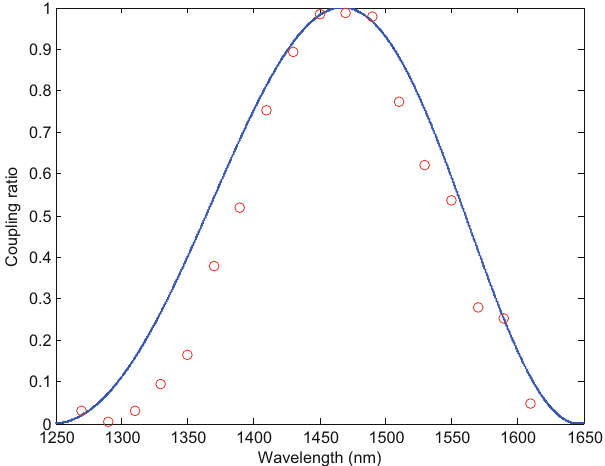
Figure 2. Relationship between the wavelength of the source and the coupling ratio. The coupling ratio of the 1 BS is defined as = , where I port 1 ( I port 2 ) is the output intensity of BS output 1(2). The theoretical r + port 1 2 relationships are based on the coupling model r = F 2 sin 2 ( C ω / F ) given in ref. 11, where F 2 is the maximal coupled power, C is the coupling coefficient, and ω is the heat source width. The red dot is the experimental measurement result, and the curve is the theoretical result. The coupling ratio changes from 0.003 to 0.968 with the wavelength changing from 1290 nm and 1470 nm. (The figure is reproduced with permission from ref.